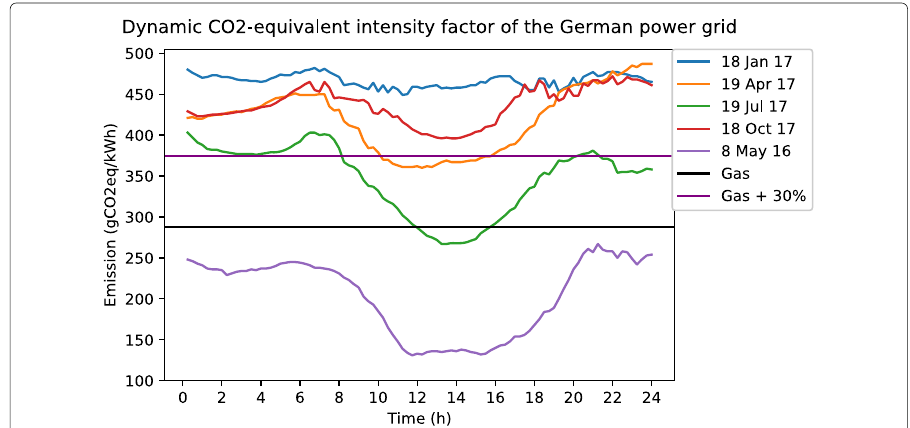
Fig. 2 Dynamic CO 2 -equivalent intensity factors for five representative days, given German generation mix